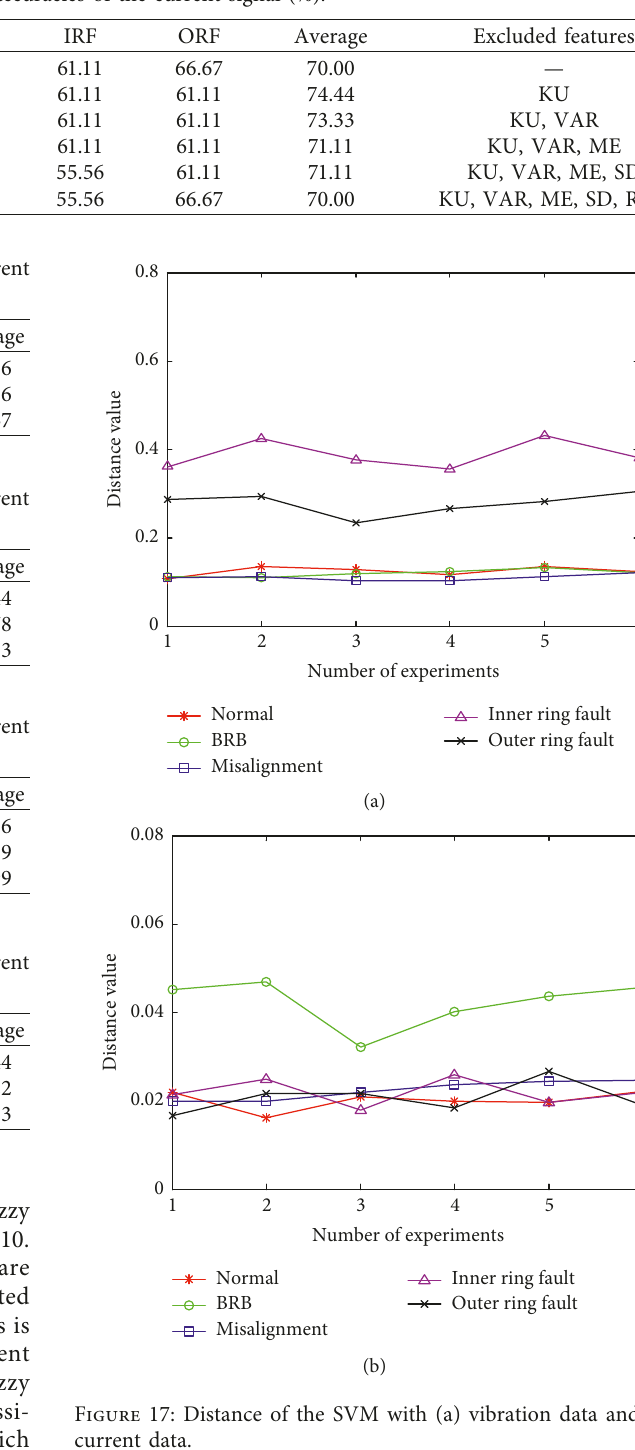
Table 5: Classification accuracies of the current signal (%).